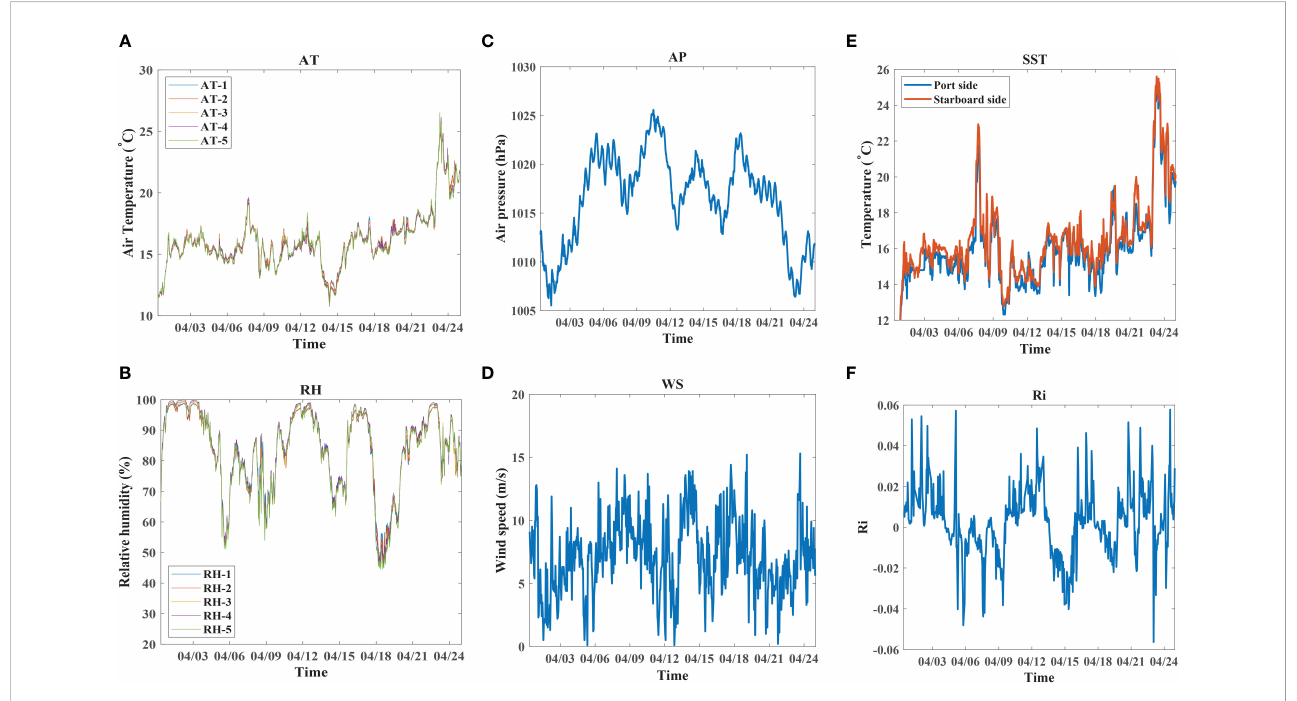
FIGURE 4 Variation curves of the acquired observation data in the time dimension. (A) AT; (B) RH; (C) AP; (D) WS; (E) SST; (F)